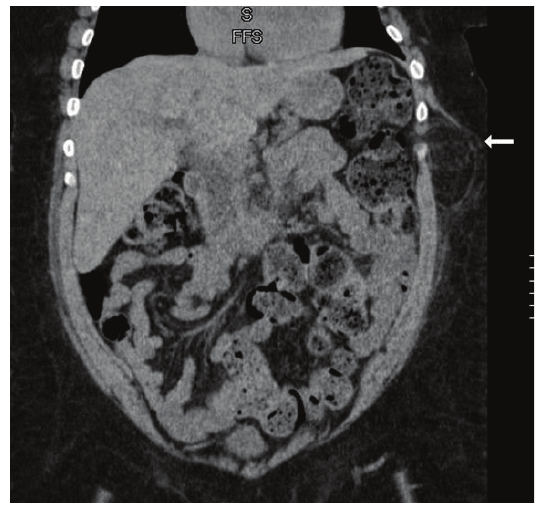
Figure 2: Coronal CT view: intercostal hernia between 10th rib and 11th rib at left midaxillary line (white arrow).